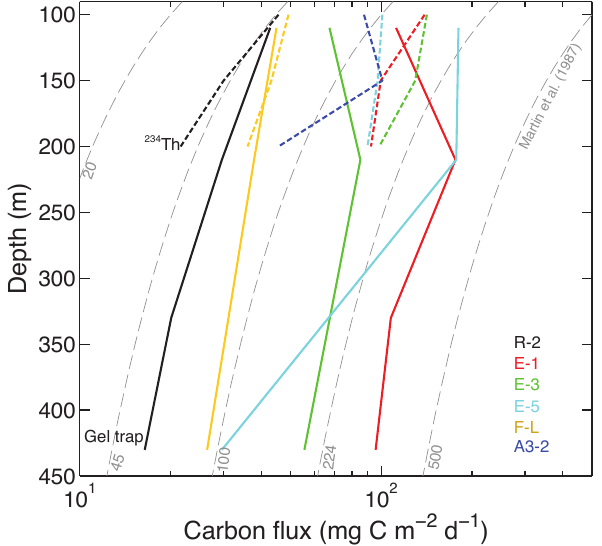
Figure 8. Variation in the carbon flux with depth estimated from gel trap and 234 Th methods. The empirical attenuation of the flux with depth (Martin curve) is represented by grey dashed lines for initial values of the carbon flux at 100m from 20 to 500mgCm − 2 d − 1 . Results show overall poor agreements between observed fluxes and the Martin curve, suggesting the complexity of the processes affect- ing the carbon flux with depth.